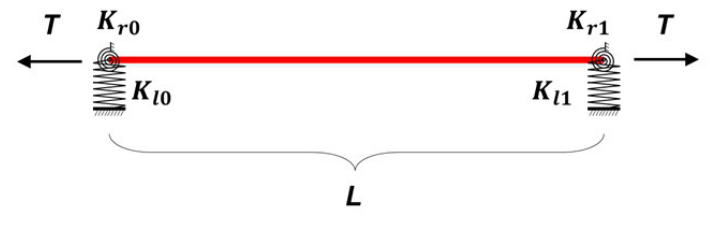
Figure 1. Simplifed cable